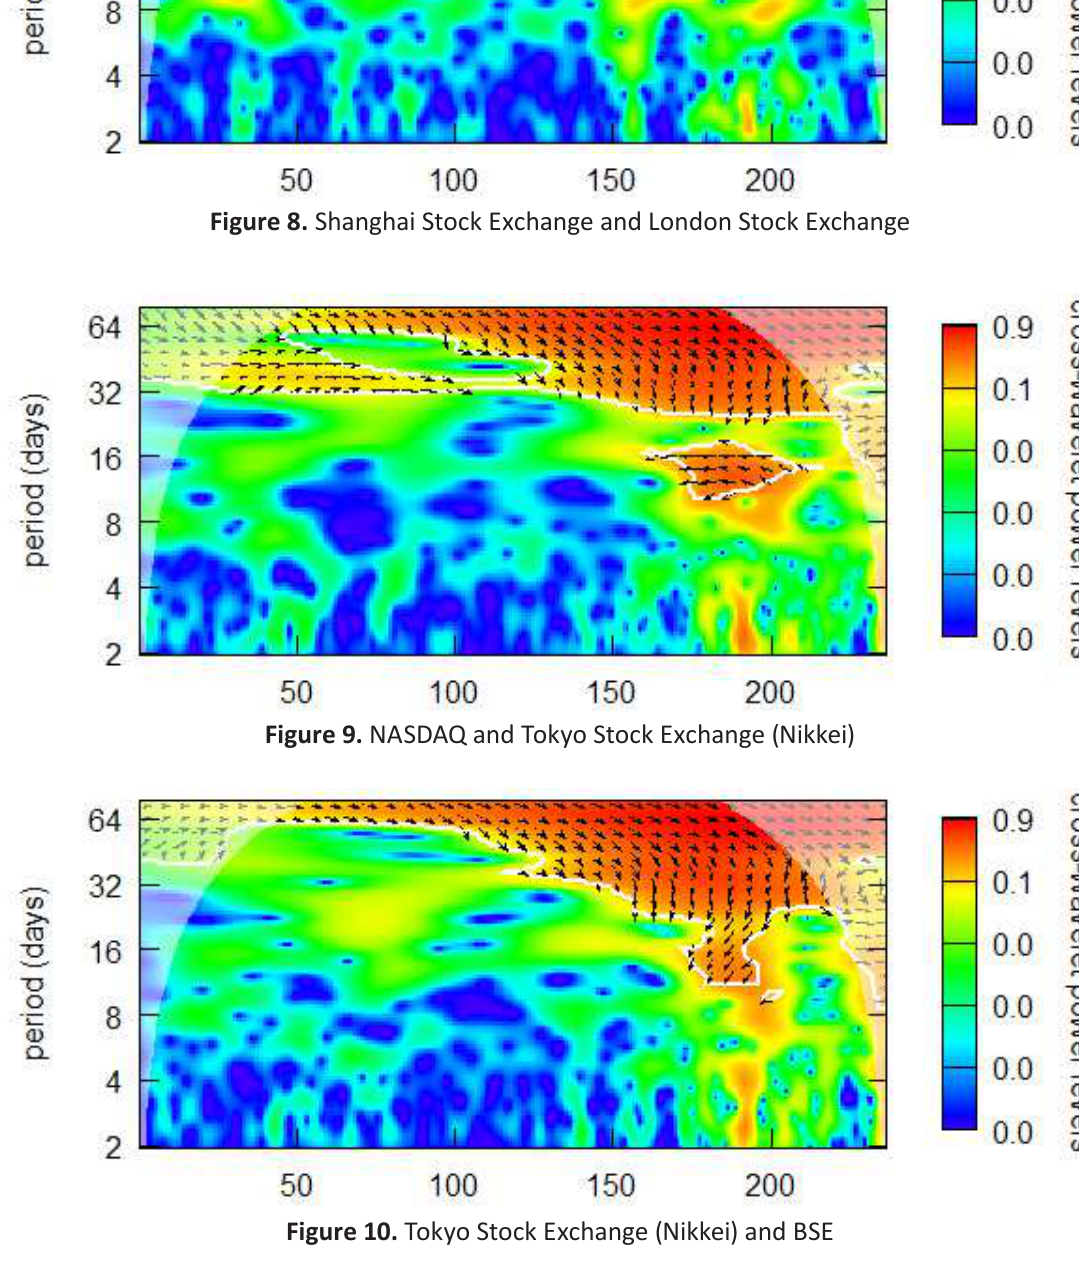
Figure 10. Tokyo Stock Exchange (Nikkei) and BSE